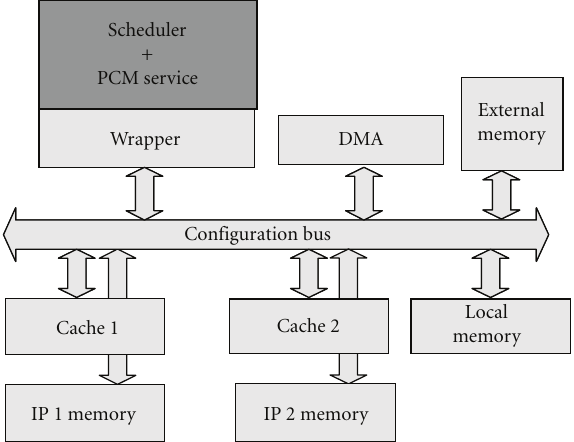
Figure 7: Simulation